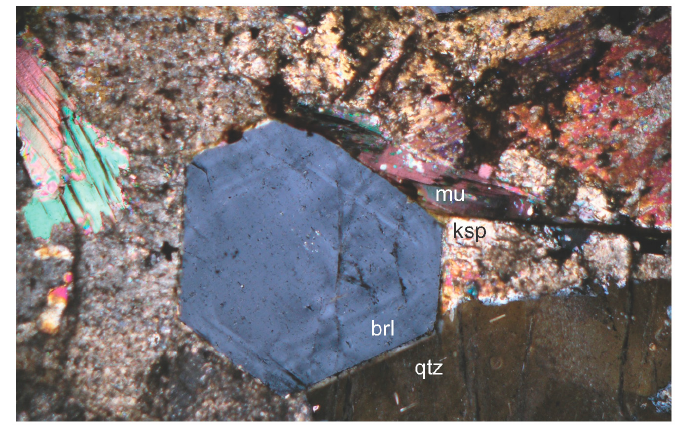
Figure 2. Emerald in pegmatite from the Poona region. Quartz (qtz), altered potassic feldspar (ksp) and muscovite (mu) are in textural equilibrium with the emerald (brl). The emerald is clear in plane polarized light, but shown here under crossed polars exhibits growth zoning. Sample MDC1811.